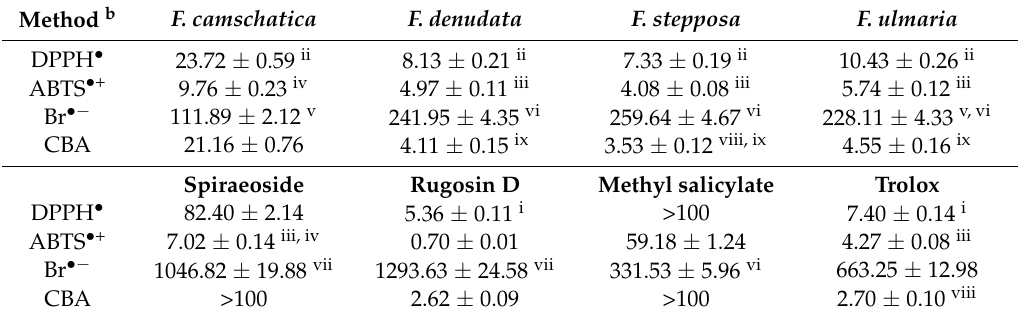
Table 7. Antioxidant activity of four meadowsweet floral tea decoctions and reference compounds a